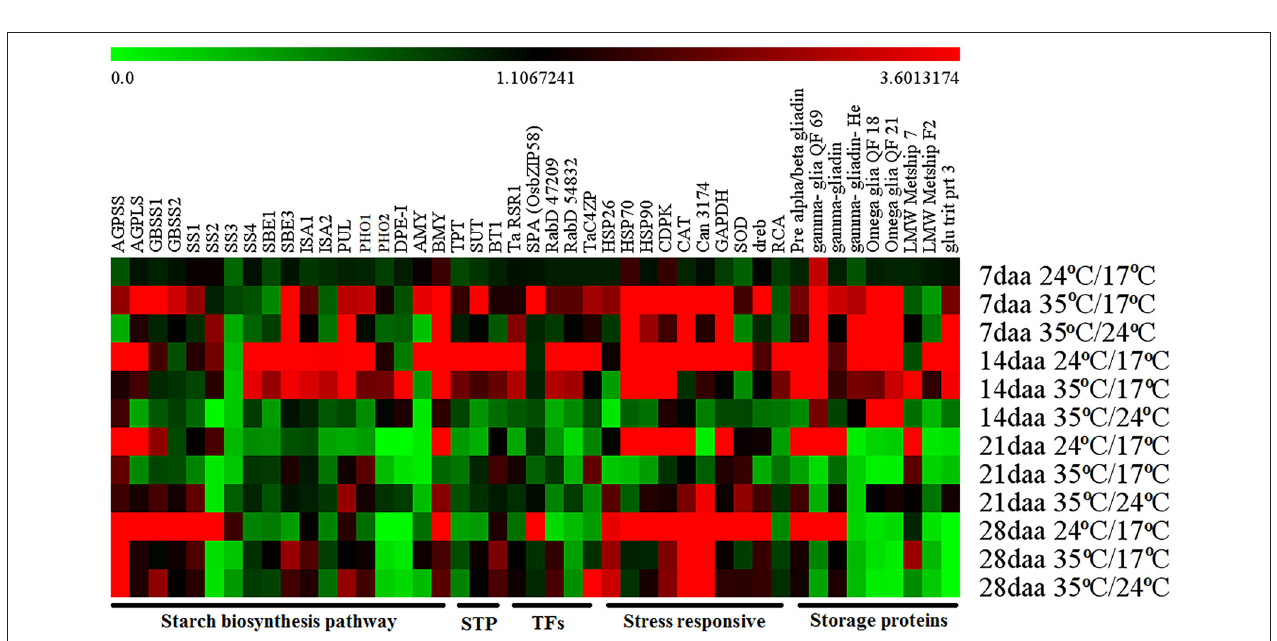
FIGURE 3 | Heat map obtained from RT-qPCR representing the gene expression at different grain developmental stages from various temperature regimes.